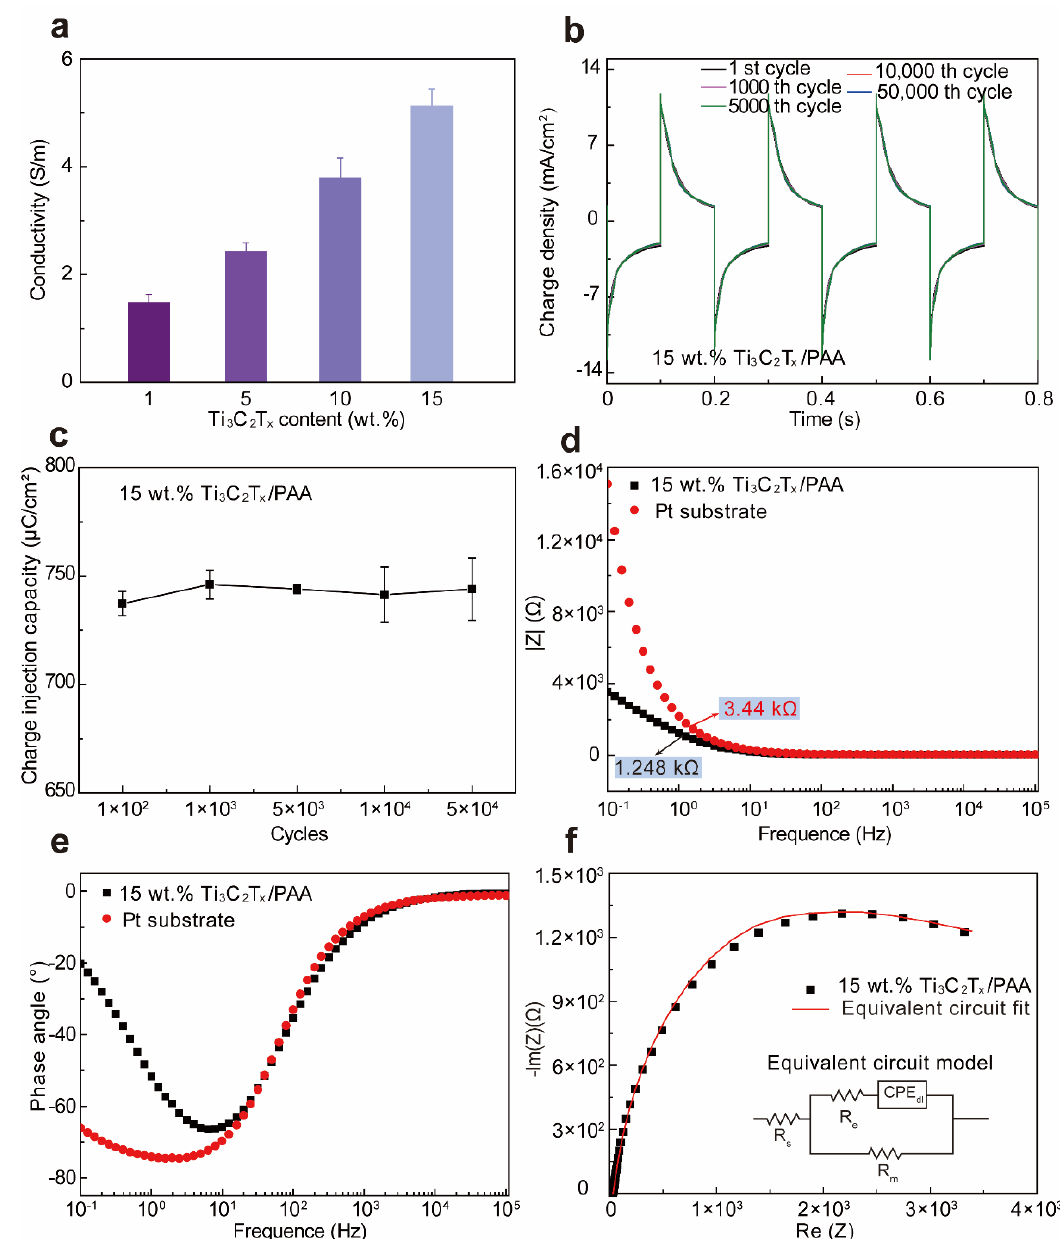
Ω. In light of the frequency range of 0.1~10 2 Hz (the low-frequency line), the 15 wt.% Ti 3 C 2 T x -PAA hydrogel represents the electric double layer capacitance (CPE dl ), membrane resistance ( R m ), and charge transfer resistance ( R e ) (Figure 3d,e). A reasonable equivalent circuit model of the 15 wt.% Ti 3 C 2 T x -PAA hydrogel in PBS solution ( p H = 7.4) is also well fitted (Figure 3f).